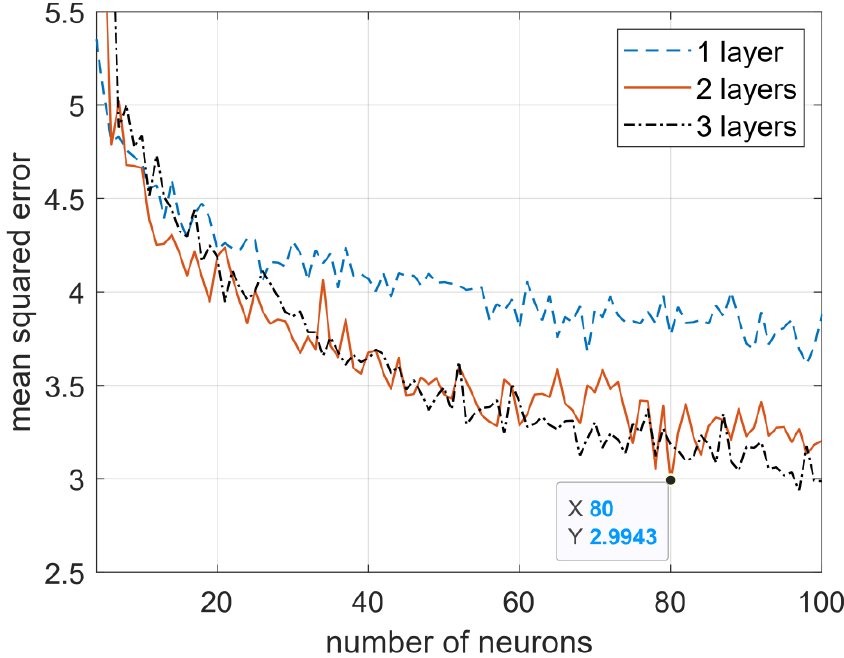
Figure 7. Mean squared error for ANNs with one, two, and three layers with different numbers of neurons.